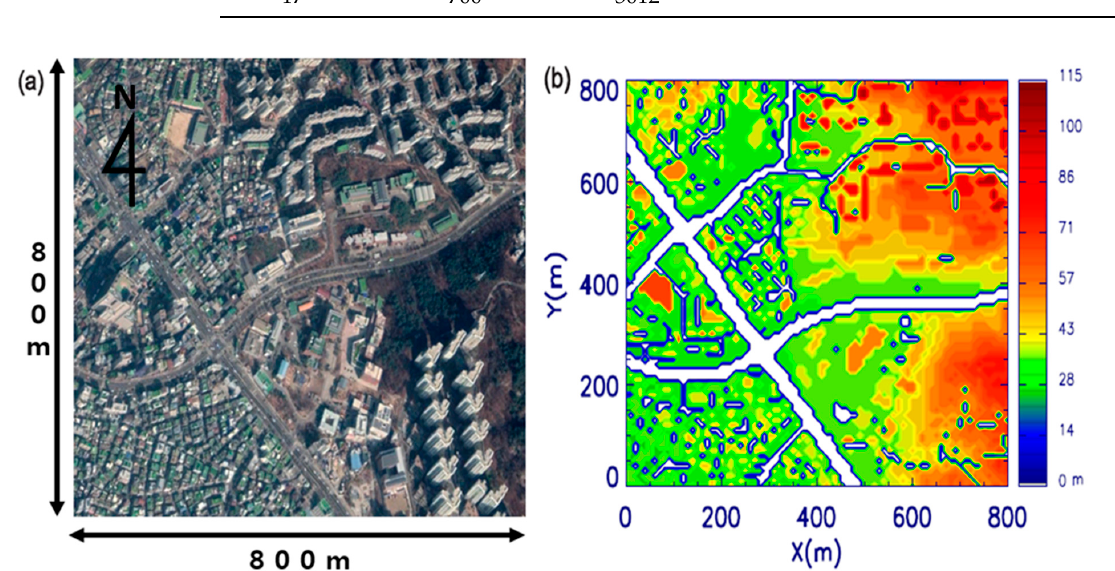
Figure 2. ( a ) Satellite observed map and ( b ) surface heights in the computational fluid dynamics (CFD) model domain for a realistic urban simulation case. The white area in ( b ) is the road. Map obtained from Google